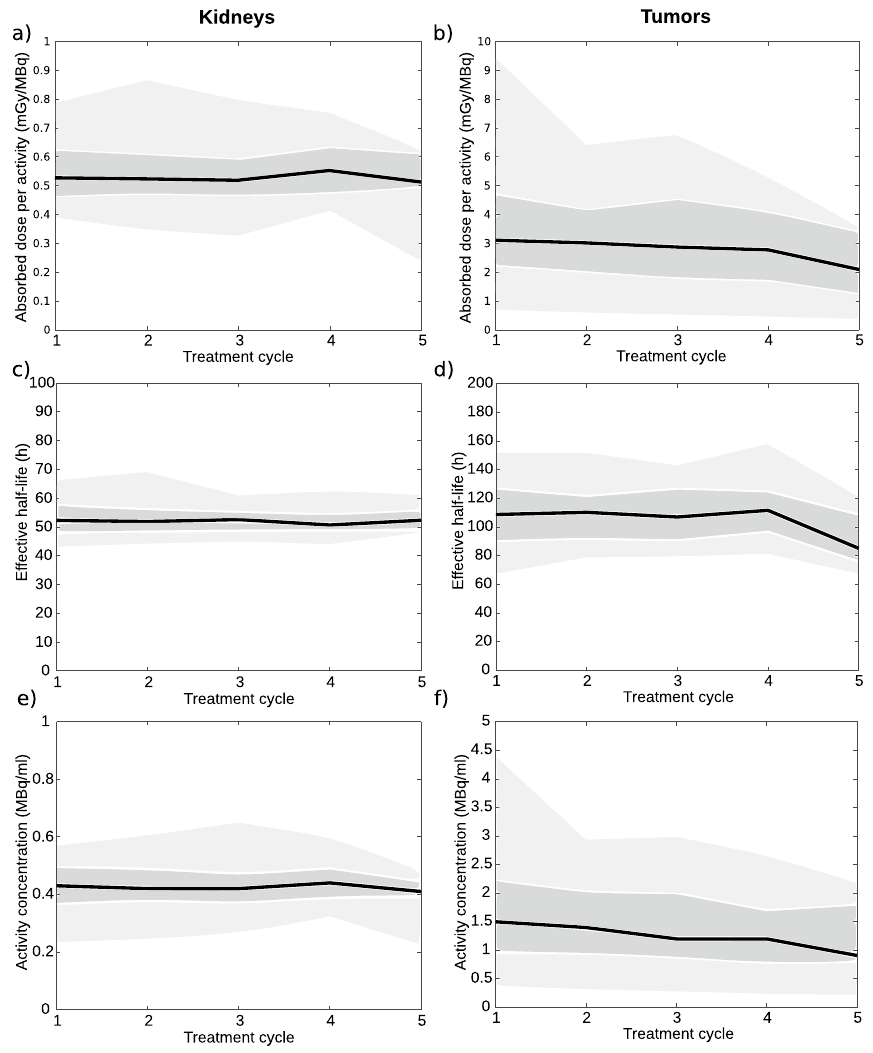
Fig. 1 Median absorbed dose per administered activity per treatment cycle to the kidneys ( a) and the tumors ( b) . Median effective half-lives per treatment cycle to the kidneys ( c) and the tumors ( d) . Median uptake at 1 d per treatment cycle to the kidneys ( e) and the tumors ( f) . Shaded regions correspond to